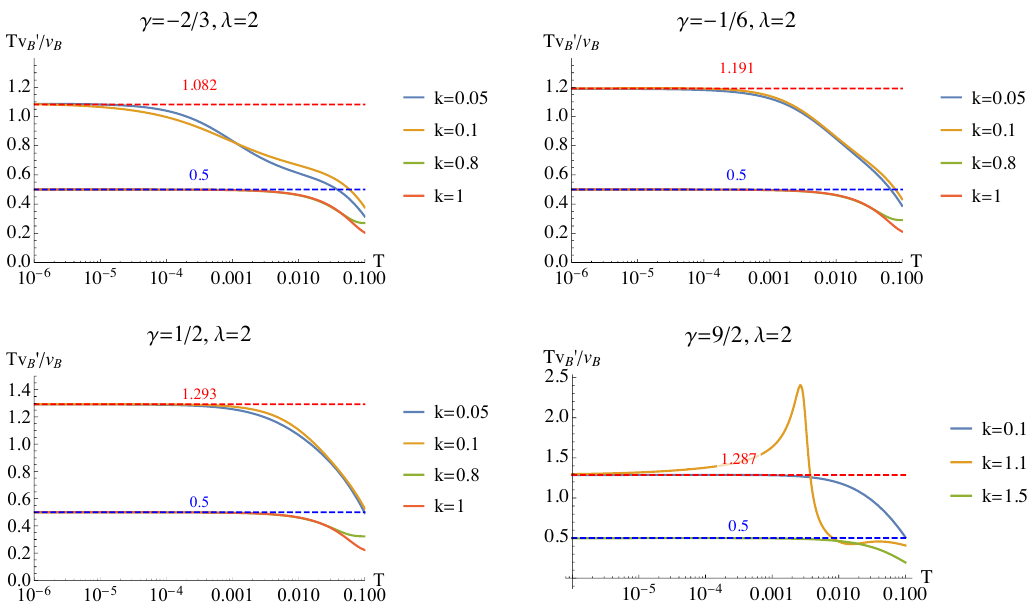
Figure 7 . Tv 0 /v B vs. T . The solid lines indicate the scaling behaviour of v B with temperature. B The blue dashed lines are the scaling exponent of AdS lines are the scaling exponent of new IR fixed point, for which α = 11+4 γ + γ 2